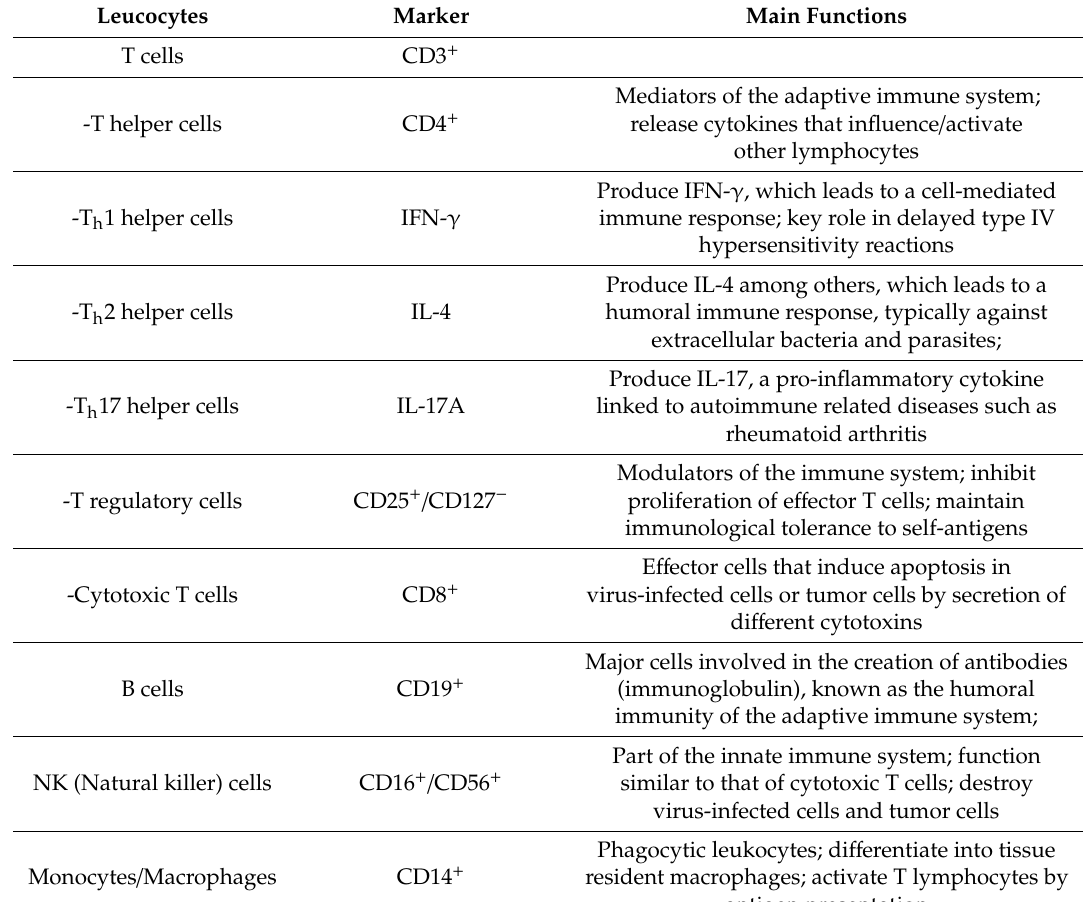
Table 1. Overview of the leucocyte subgroups analyzed in the present